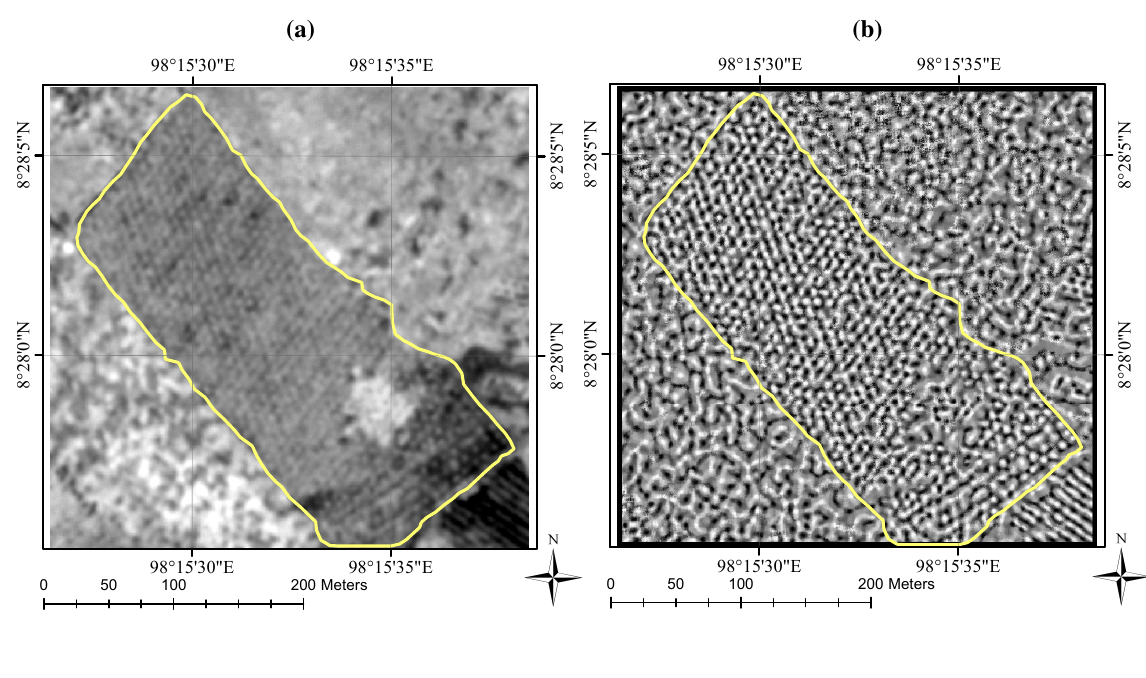
Figure 9. The result from using excess green index in the detection process: ( a ) excess green index of the image shown in Figure 4a and ( b ) its rank transformation.